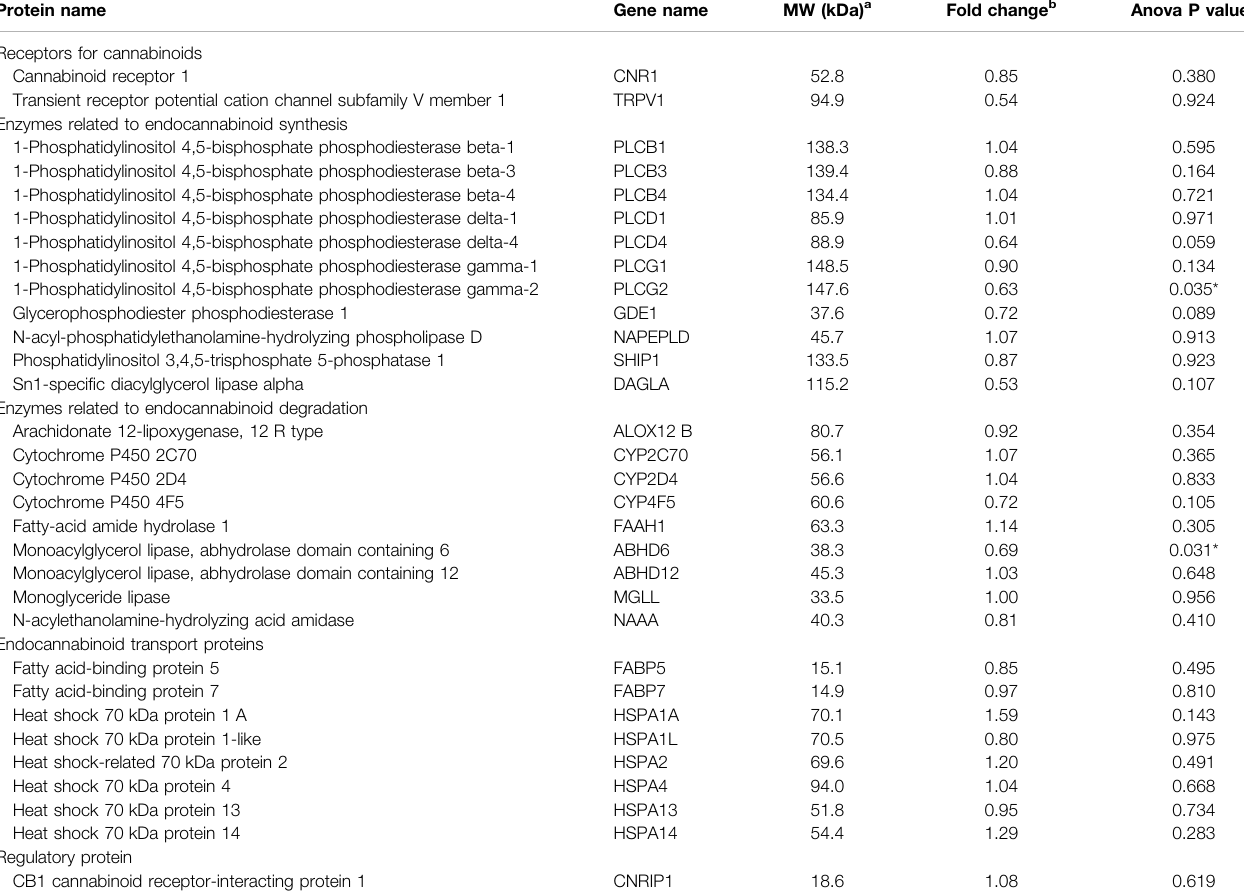
TABLE 1 | Expression alterations of the endogenous cannabinoid system-related proteins in the VTA after chronic morphine exposure. Protein